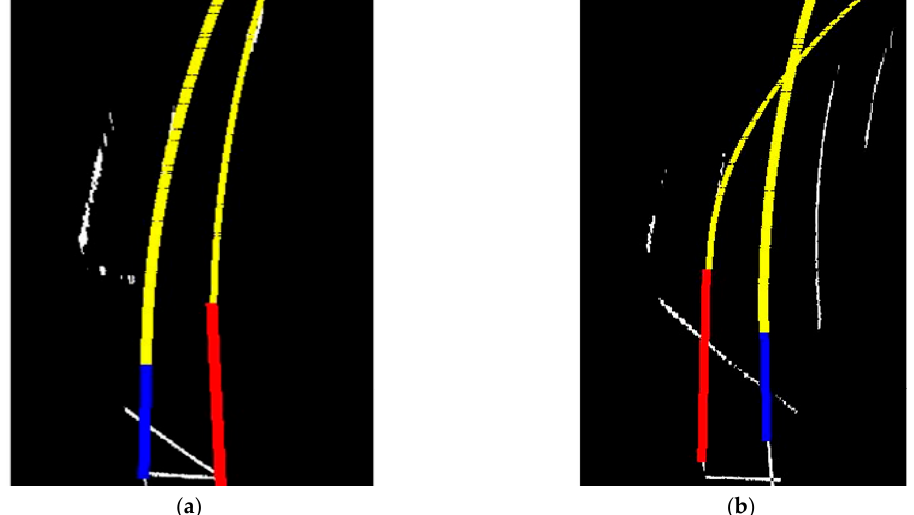
Figure 24. The real experiment result of the cure lane detection based on Kalman filter (yellow); ( a ) Output Result of Parabolic Curve Detection, ( b ) Result aftermath of shadow reflection.